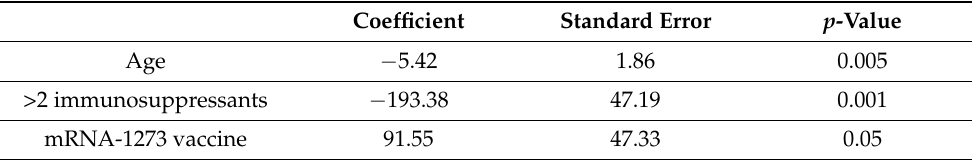
Table 4. Multivariable linear regression analysis of factors involved in determining anti-S IgG antibody titer.